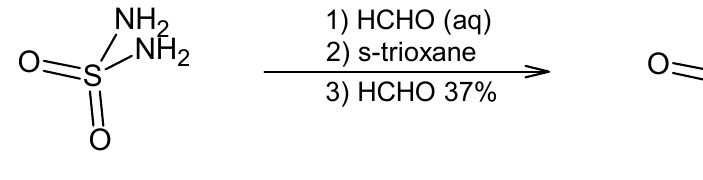
Figure 1. Synthesis of TETS.